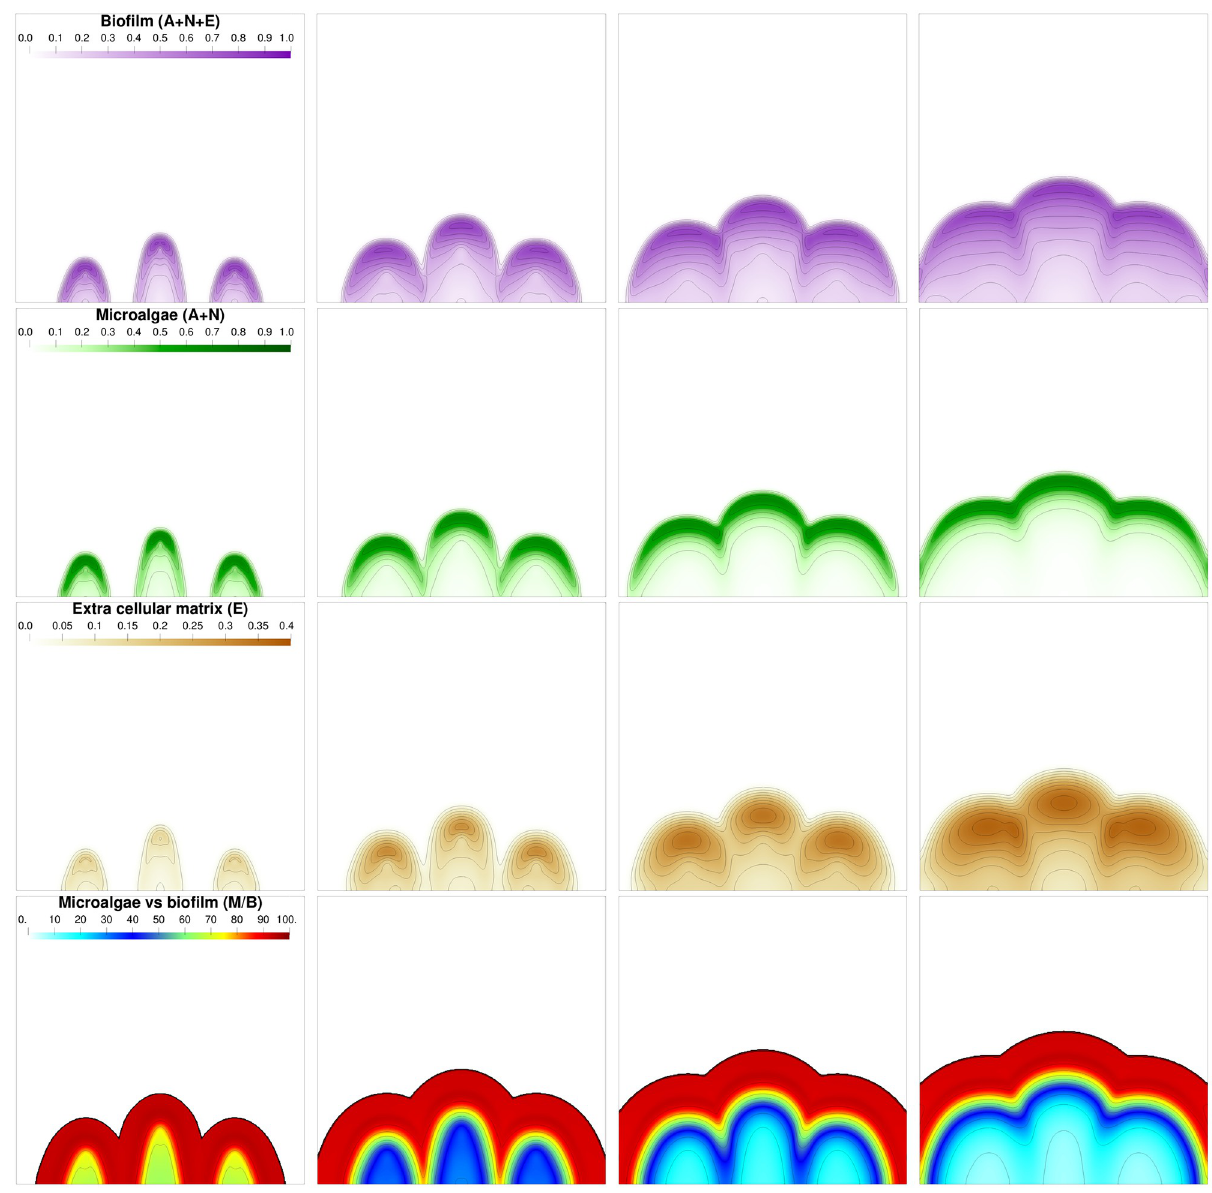
Fig 7. Biofilm volume fractions and composition at different times: t = 5, t = 10, t = 15 and t = 20 days from left to right. First row: whole biofilm volume fraction B = A + N + E . Second row: microalgae volume fraction M = A + N . Third row: extra cellular matrix volume fraction E . Last row: ratio (%) of living biomass over the whole biomass M / B